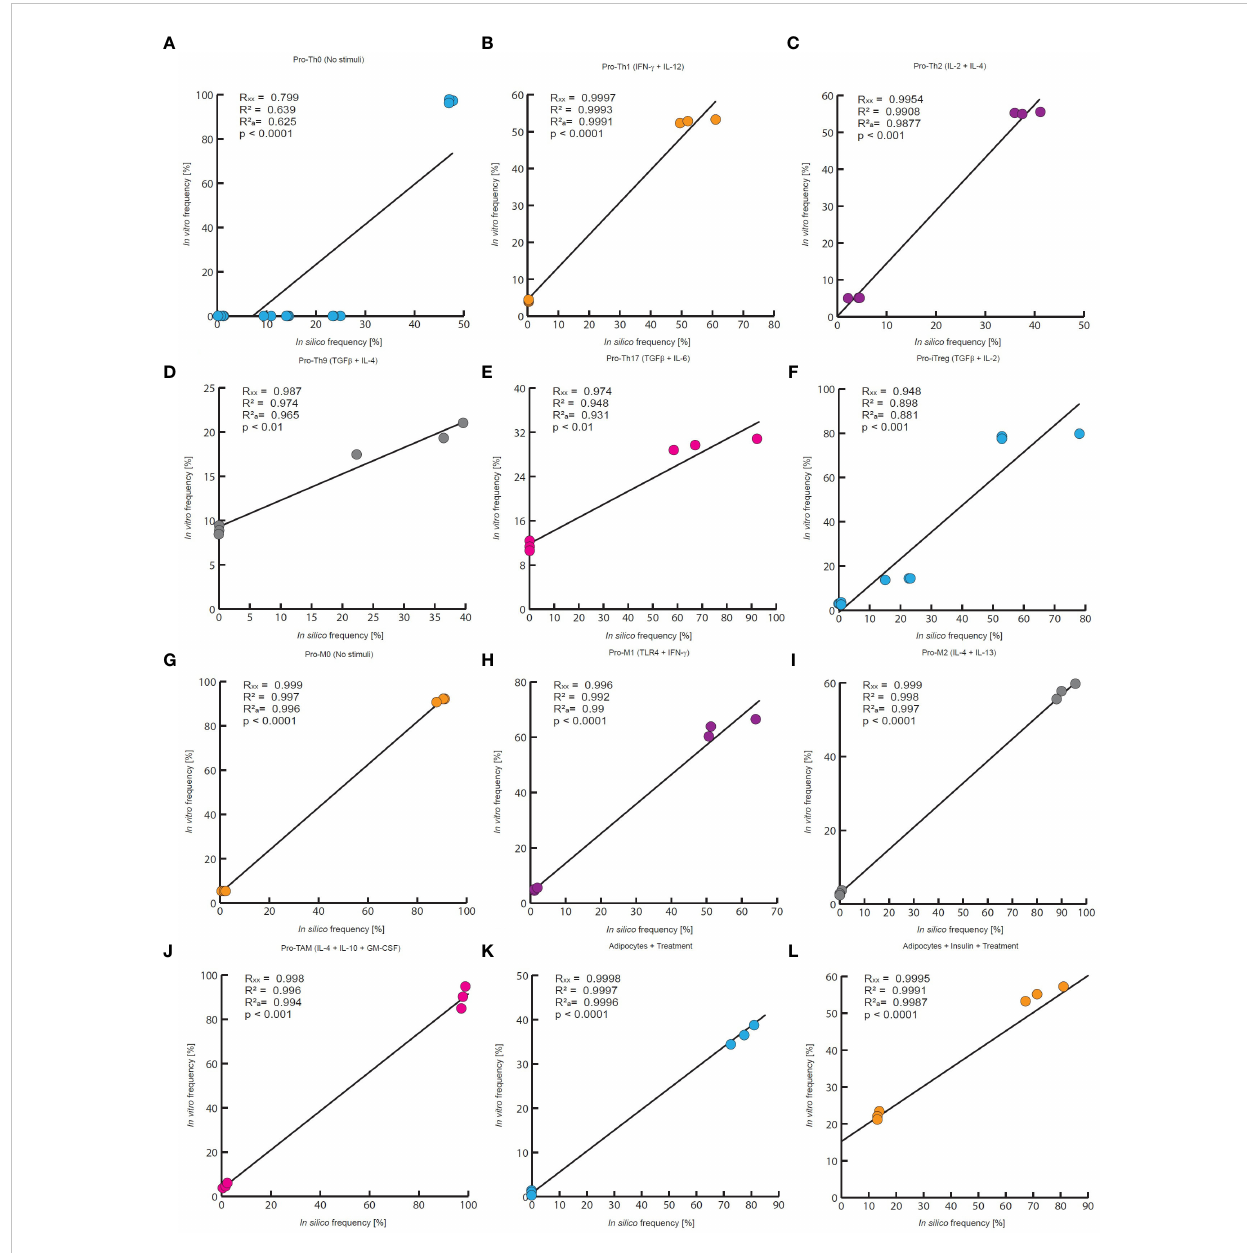
FIGURE 4 Quantitative evaluation of stochastic models of the VAT cells. In this work the quantitative accuracy of all models was tested by a multivariate correlation analysis. In all panels are compared the outcomes of each model to experimental measurements of every phenotype frequency. Each panel reports the multiple correlation coef fi cient (R xx ), the Pearson correlation coef fi cient (R 2 ), the adjusted correlation coef fi cient (R 2 a ) as well as the p-value. (A) in silico outcomes vs in vitro data of CD4+ T cells without stimuli, (B) CD4+ T cells treated with IFN- g and IL-12, (C) IL-2 and IL-4, (D) TGF- b and IL-4, (E) TGF- b and IL-6, (F) TGF − b and IL-2. The data for (A – C, E) , and (F) was taken from (31), and the data for panel D was obtained from (24). (G) Macrophages without treatment, (H) macrophages treated with IFN- g and TLR4 ligands, (I) IL-4 and IL-13, (J) GM-CSF, IL-4 and IL-10. The experimental data of (G – I) was taken from (32), and the data of panel J was taken from (33). (K) Adipocytes treated with an in fl ammation inducer, (L) and adipocytes treated with TNF. For both panels the experimental data was taken from